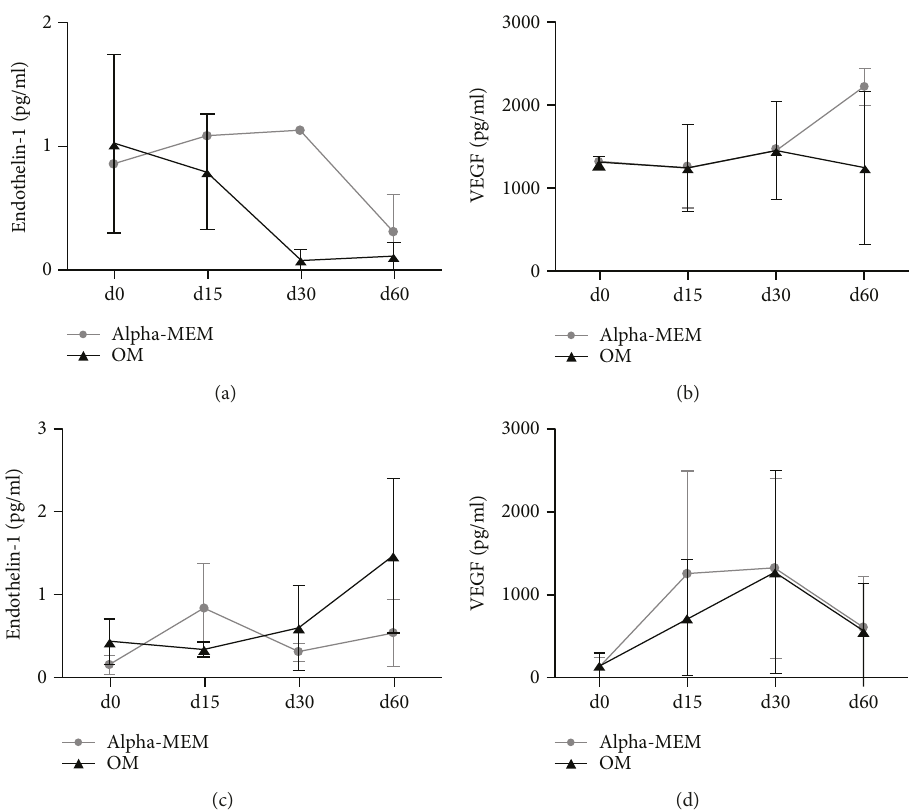
Figure 8: Secretion of ET1 and VEGF by ASCs and SVF plated on SB by ELISA assay. The levels of ET-1 and VEGF were dosed in cell culture supernatants at the beginning and during the culture. In ASC cultures, both ET-1 and VEGF were produced with and without osteogenic factors. ET-1 levels decreased, whereas high VEGF levels were constantly released over time (a, b). In SVF cultures, ET-1 showed an increasing trend of secretion with osteogenic factors, compared to a variable production in regular medium (c). VEGF levels increased until 30 days of culture, then they decreased with and without osteogenic factors